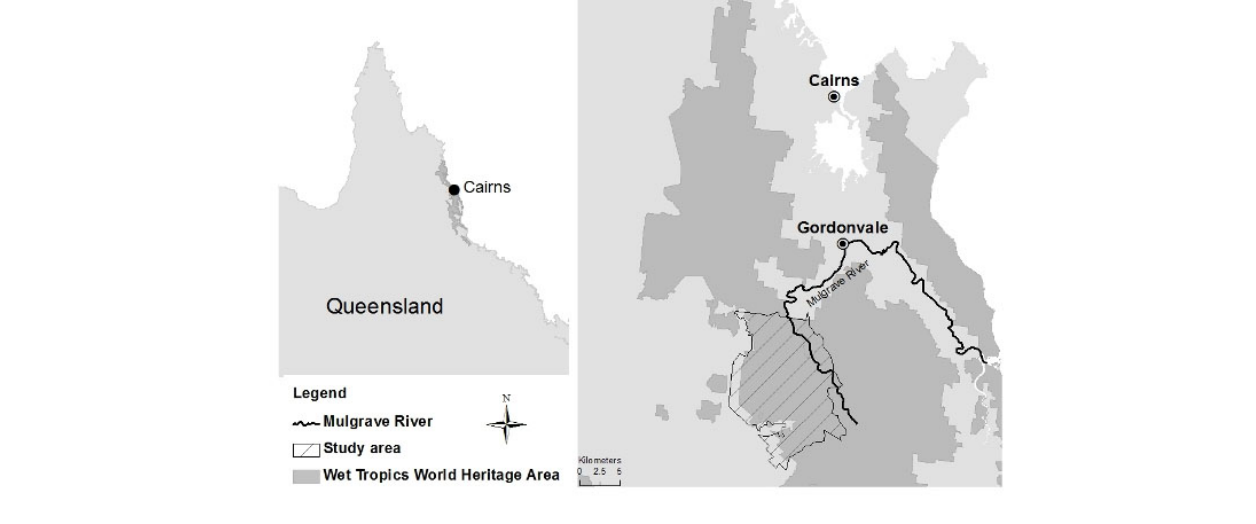
Fig. 1. The study area in the Mulgrave River valley, in the Wet Tropics Worls Heritage Area, Queensland,